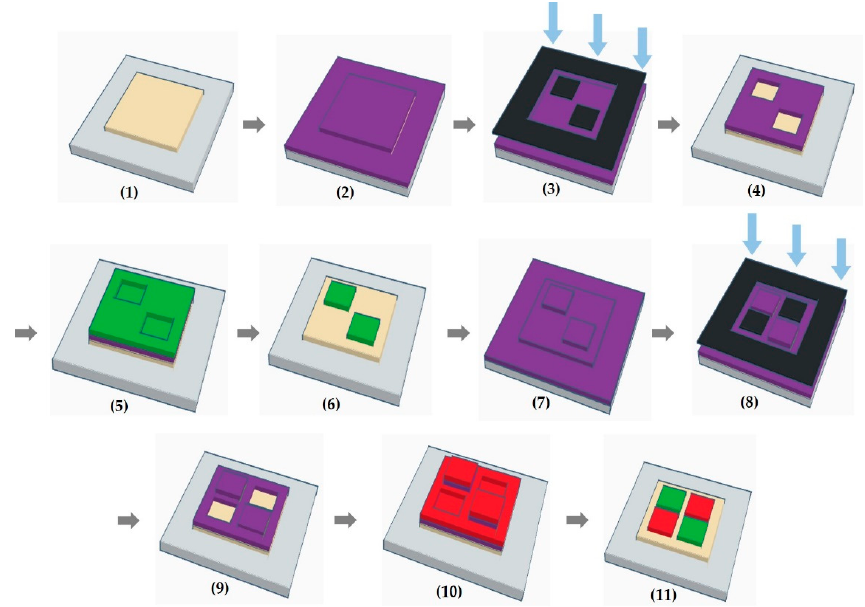
Figure 8. Schematic illustration of the photolithographic patterning process about two-color pixel patterning.